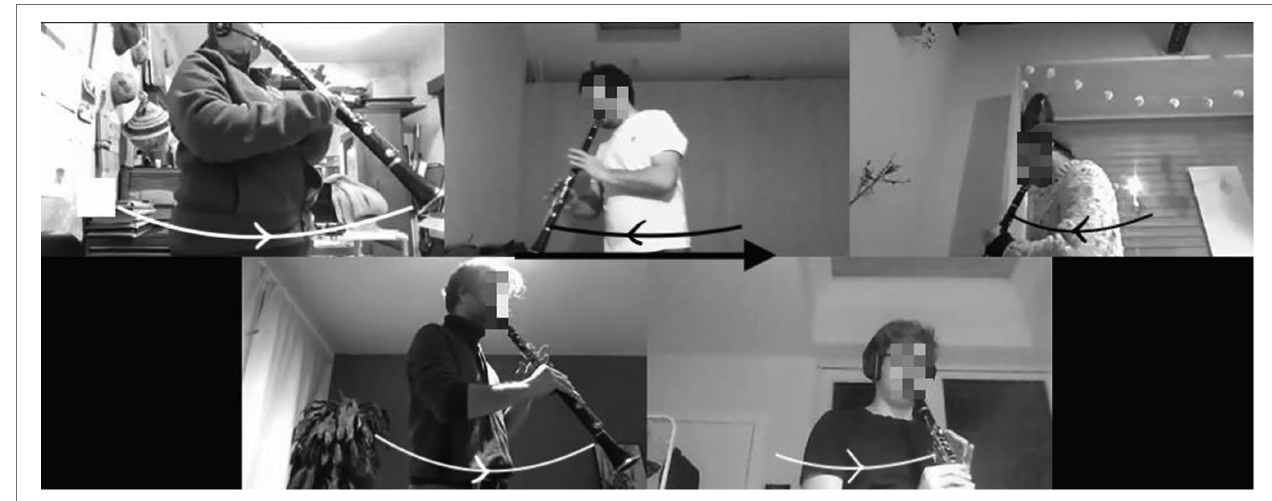
FIGURE 4 | Playing a musical pattern while using lateral movements of the upper body. The arrows show the direction of the